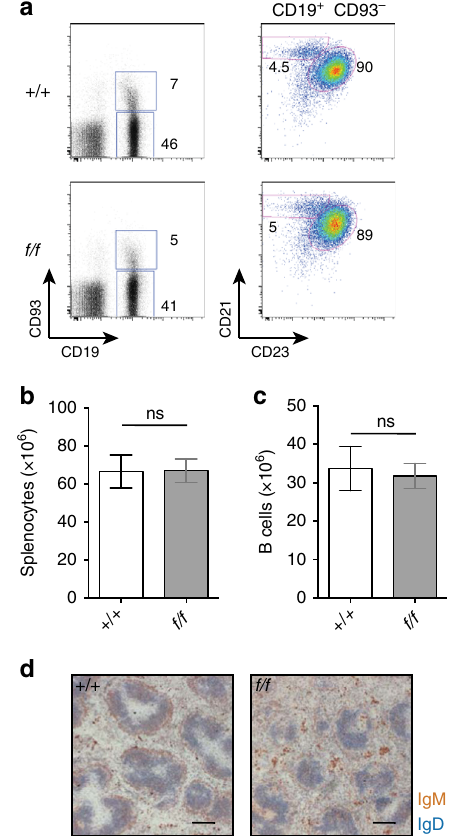
Fig. 1 Intact CD23 + B-cell compartment despite deletion of Prmt1 .